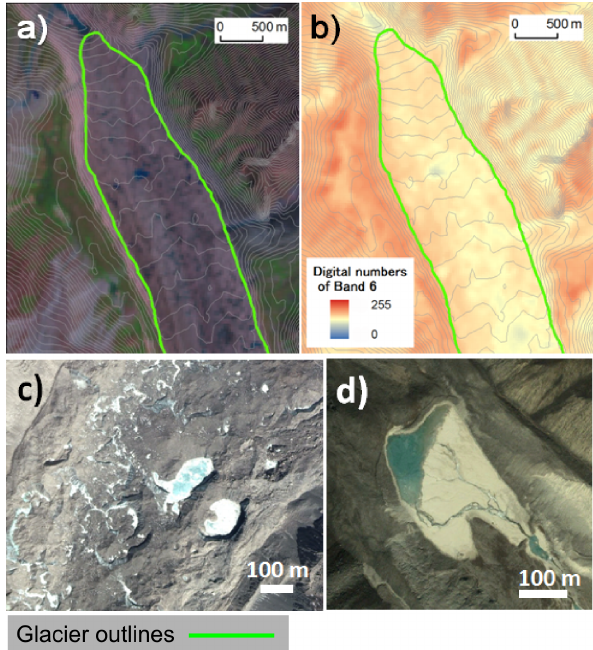
Figure 7. Example of glacier outlines generated for the GGI using contour lines at 20m intervals. The full extent of debris-covered glacier surfaces can be identified using both the inflections of con- tour lines (a) and thermal band imagery (band 6) (b) . Background imageries are false colour (bands 7, 4, and 2 as RGB) (a) and ther- mal band (band 6) (b) Landsat imagery (30.911 ◦ N, 79.088 ◦ E) ac- quired on 1 August 2001, at path 145 row 39. Thermokarst features and supra-glacial lakes with ice cliffs (27.911 ◦ N, 86.949 ◦ E) (c) and a non-glacial lake surrounded by smooth terrain (28.083 ◦ N, 86.471 ◦ E) (d) are used to differentiate between debris-covered glacier surfaces and ice-free areas. Both (c) and (d) are screenshots from Google Earth TM , © 2014